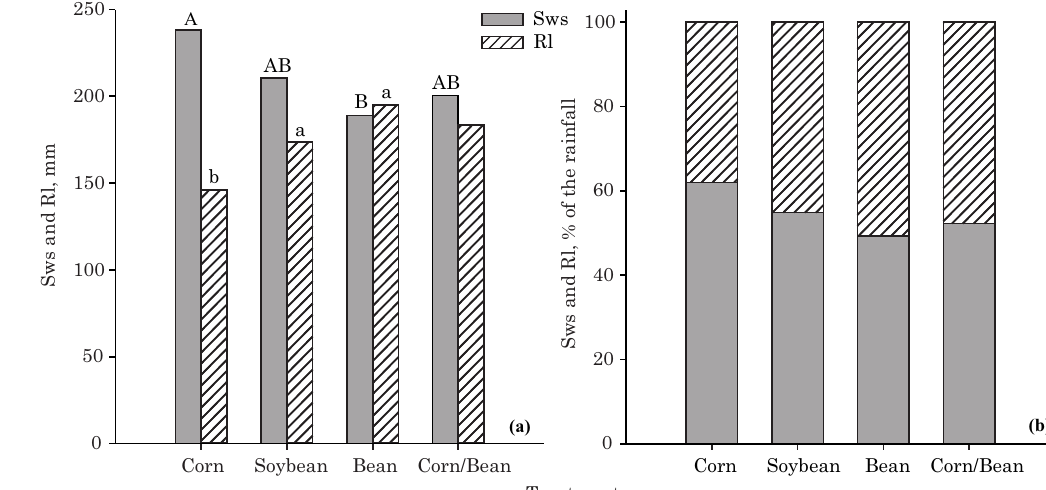
Figure 1. Soil water infiltration + interception by crops + soil surface storage depths, Sws, and runoff depth, Rl, adjusted for rainfall intensity of 64 mm h -1 , in the sum of four rainfall tests, under four treatments, on a Humic Dystrudept soil: (a) Sws and Rl in mm; (b) Sws and Rl in % of the applied rainfall depth. Uppercase letters compare Sws (CV = 13.4 %) and lowercase letters compare Rl (CV = 10.3 %), by Tukey’s test